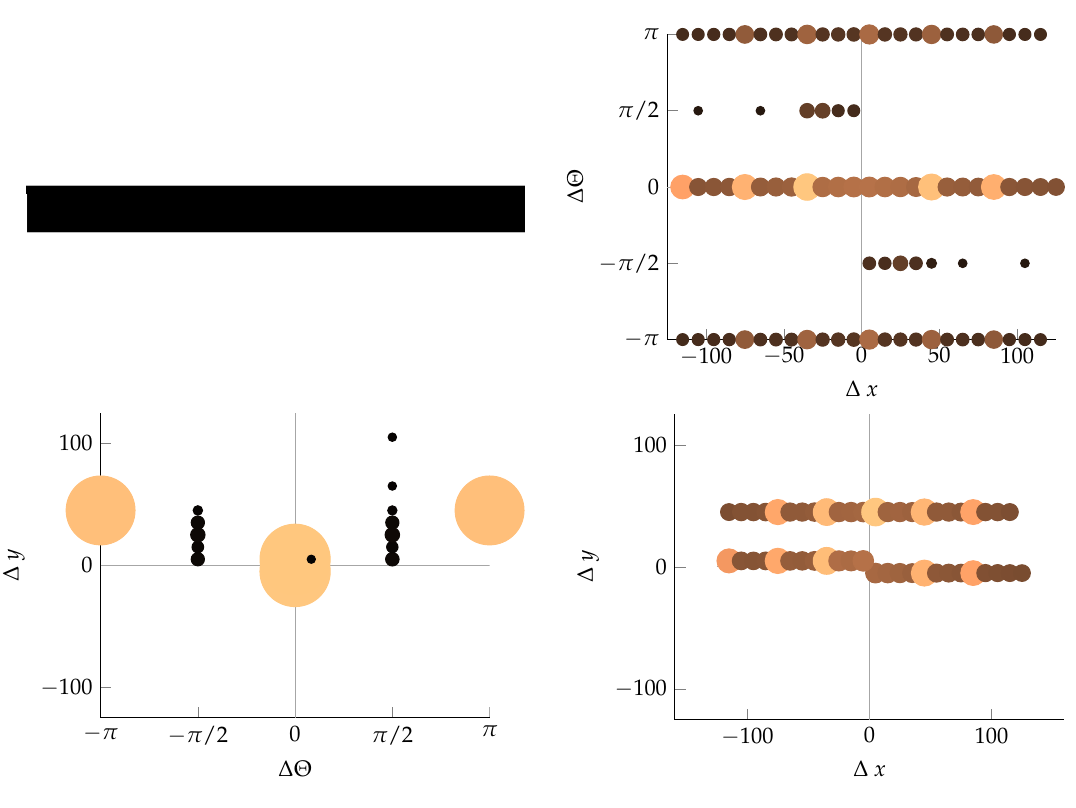
Figure B3. Geometry example rectangle.